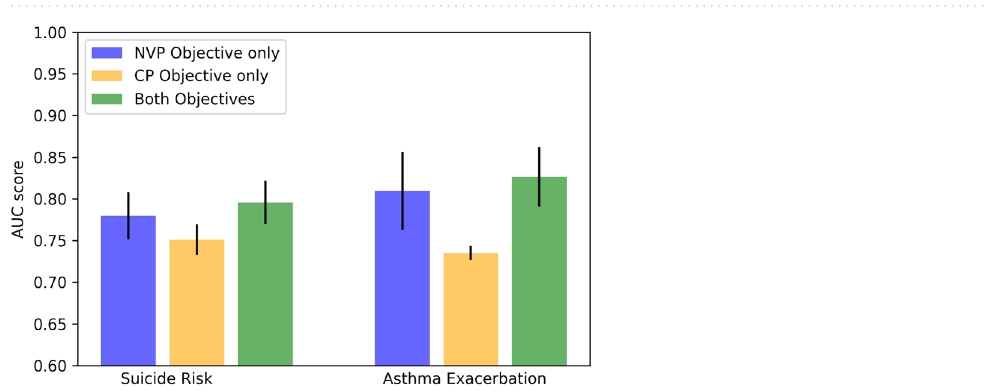
Figure 8. Effectiveness of adding different input information from different order.